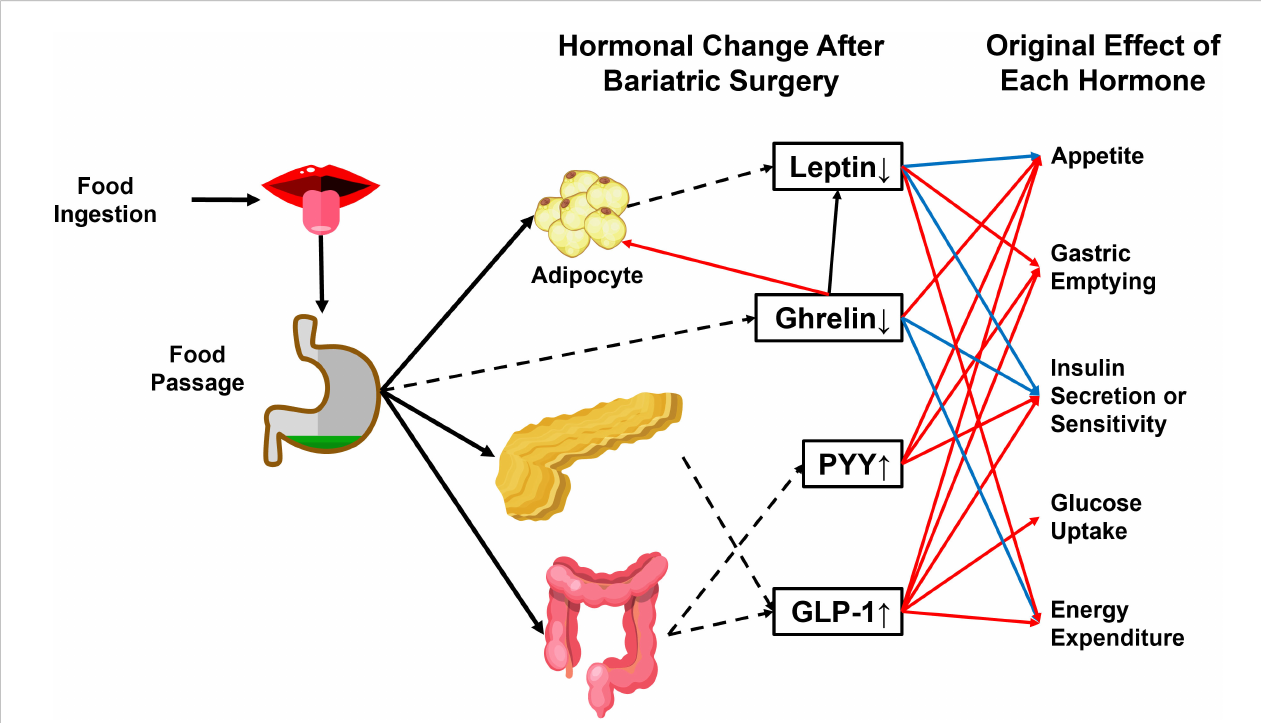
FIGURE 3 Physiological effects of crucial hormones that are altered after bariatric surgery. GLP-1 and PYY are gut-secreted hormones with anti-obesity and antidiabetic actions. The passage of food can stimulate both hormones through the gastrointestinal tract. Ghrelin and leptin are reduced after bariatric surgery. Ghrelin induces energy storage in the form of fat by promoting adipose tissue deposition and fatty acid oxidation, reducing energy expenditure, and blocking insulin secretion. Leptin has an antagonistic effect on ghrelin. PYY, Peptide YY. GLP-1, glucagon-like peptide 1. Dashed arrowhead, hormone secretion. Blue arrowhead, inhibitory effect. Red arrowhead, stimulatory